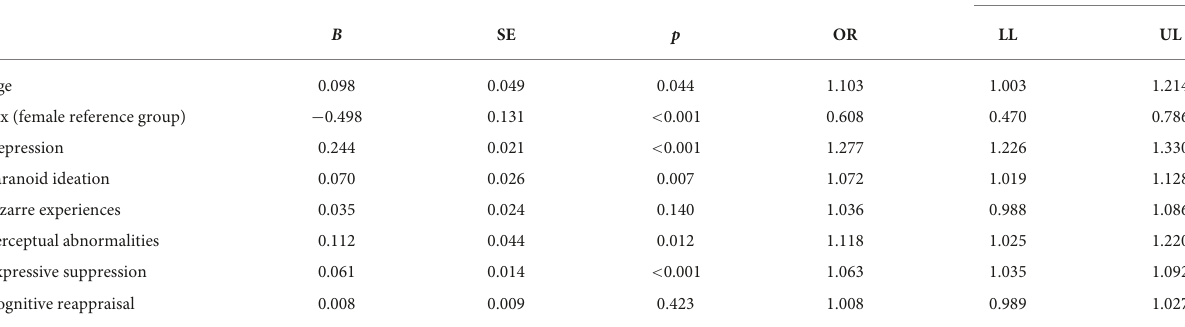
TABLE 3 Logistic regression examining the relationship between psychotic experiences, depression, emotion regulation, and suicidal ideation ( n =